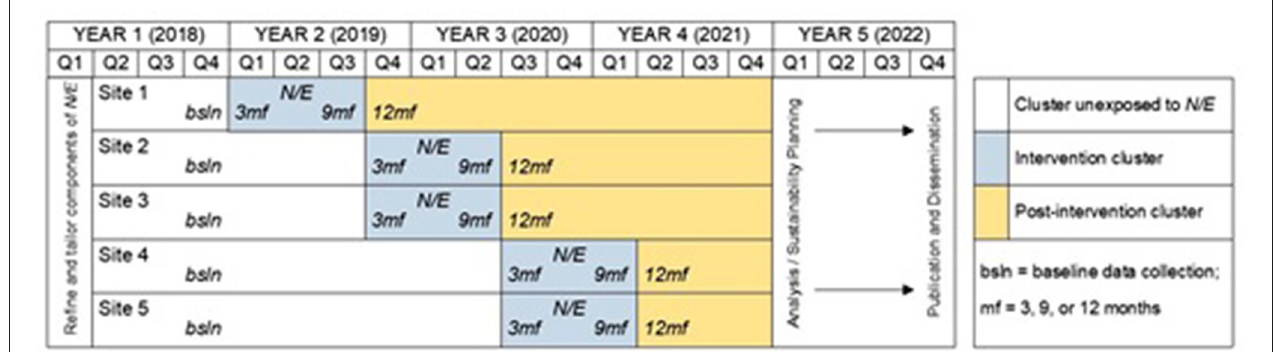
FIGURE 2 | Trial design and timeline for implementing NE relative to grant and sites/schools.